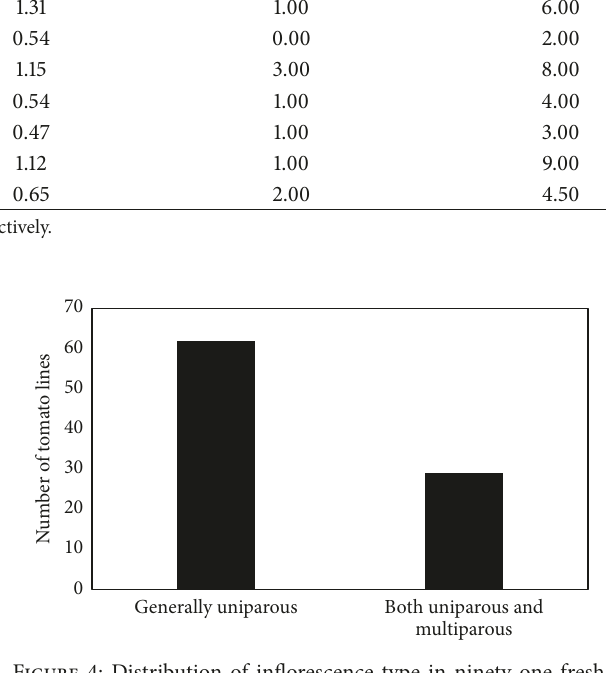
Figure 4: Distribution of inflorescence type in ninety-one fresh- market tomato